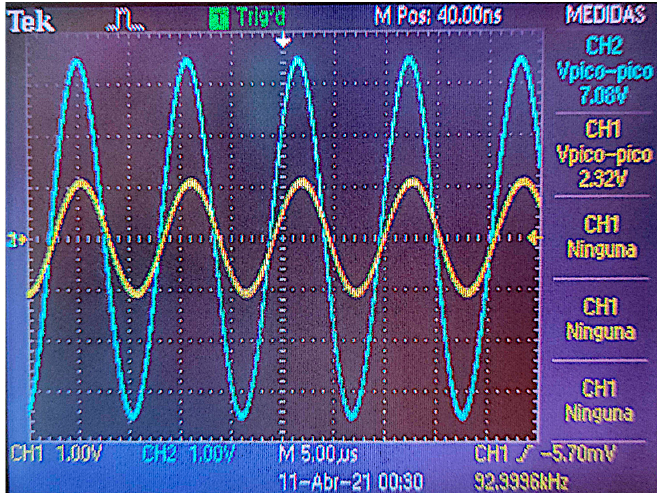
Figure 5. Example of generated and obtained signals.